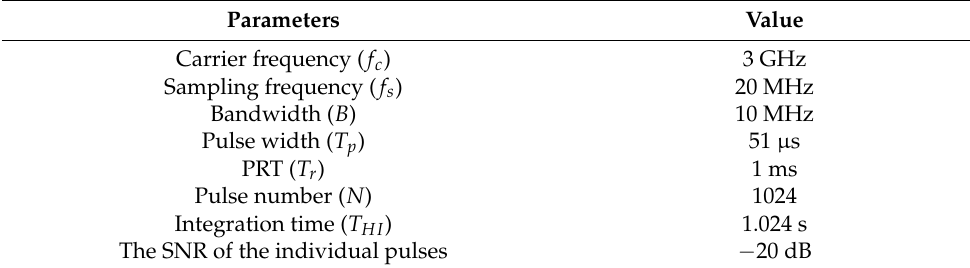
Table 1. Main parameters of the radar.